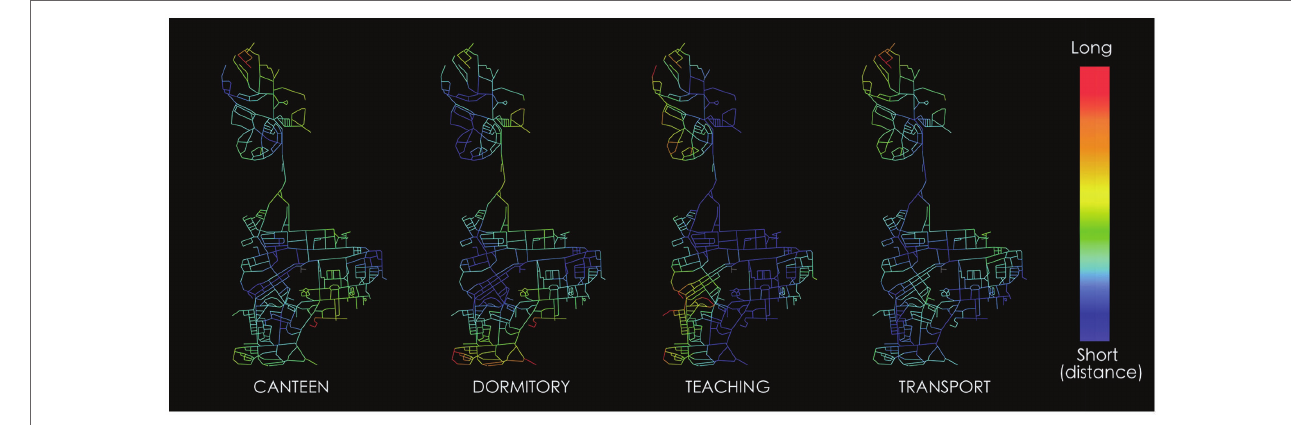
FIGURE 4 | Quantify different attractions by metric step depth analysis.